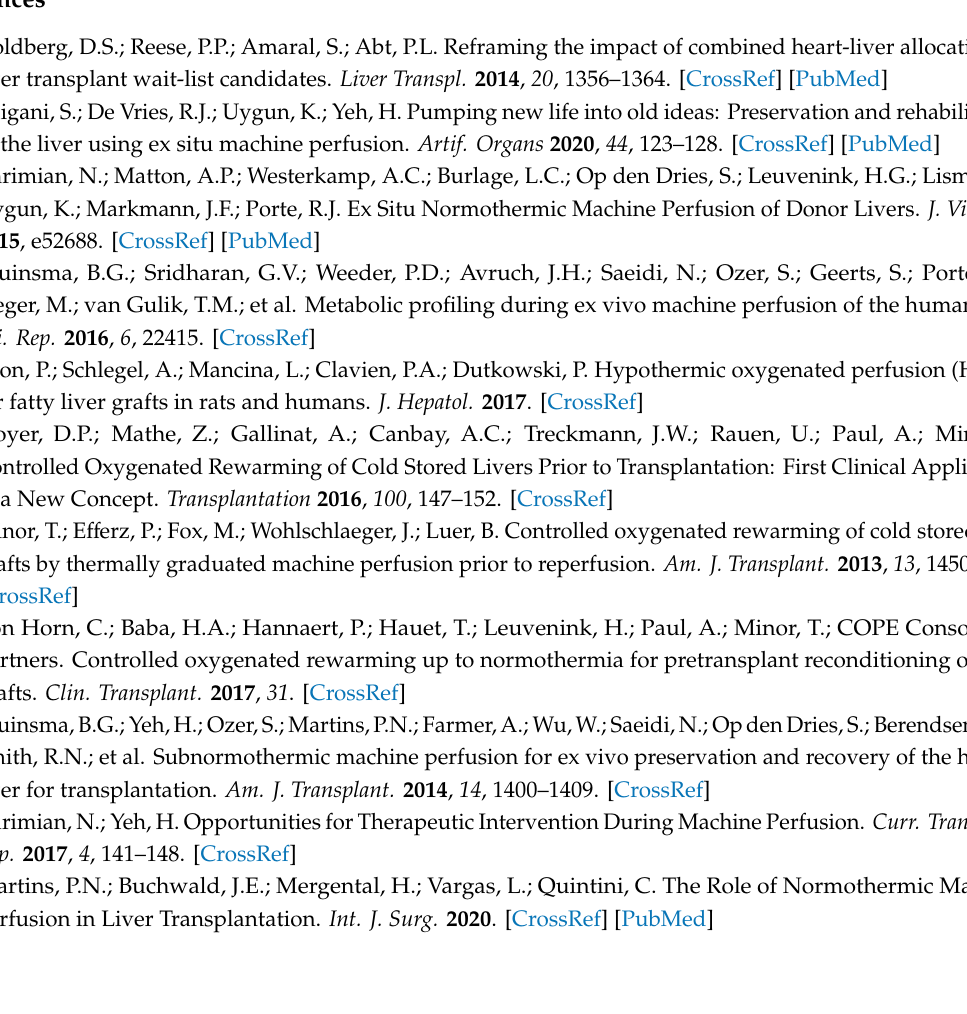
Table S1: Perfusate Compositions, Figure S1: NAD + content in livers during SNMP vs. NMP, Figure S2: Bile acid composition during SNMP vs. NMP, Dataset S1: Complete untargeted metabolomic profile